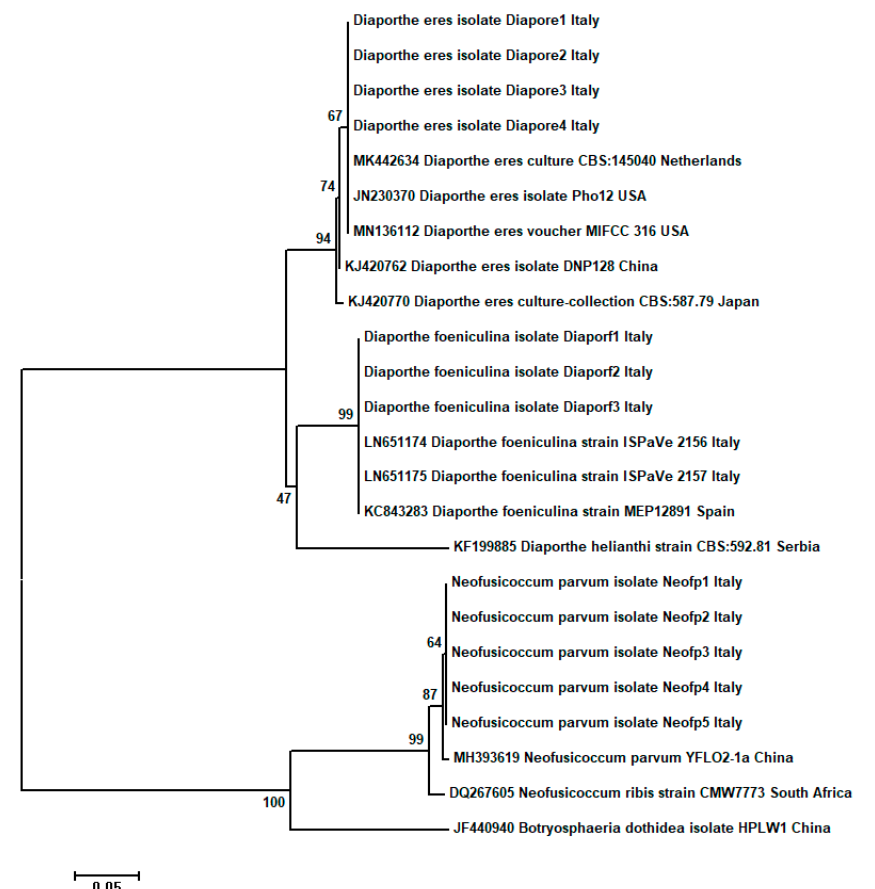
Figure 4. Molecular phylogenetic tree obtained through neighbor-joining (NJ) method based on the 24 ACT gene sequences data (298 bp) from fungal isolates in the present study and published sequences. The fungal species ( D. helianthi and B. dothidea ) were used as outgroups in the analysis. The optimal tree with the sum of branch length = 0.90526841is shown. The confidence probability estimated using the bootstrap test (1000 replicates) is shown next to the branches. The tree is drawn to scale, with branch lengths in the same units as those of the evolutionary distances used to infer the phylogenetic tree. The evolutionary distances were computed using the Tajima–Nei method and are in the units of the number of base substitutions/site. Scientific names of the fungi along with collection place, isolate abbreviation and GenBank AC number are shown in the trees.